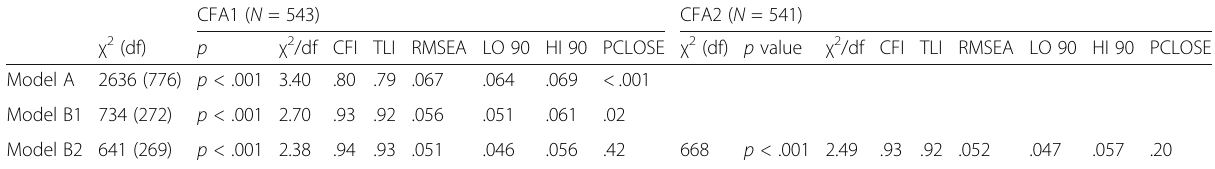
Table 3 Goodness of fit indices for the model of the confirmatory factor analyses for the URS with sample 2 (CFA1) and sample